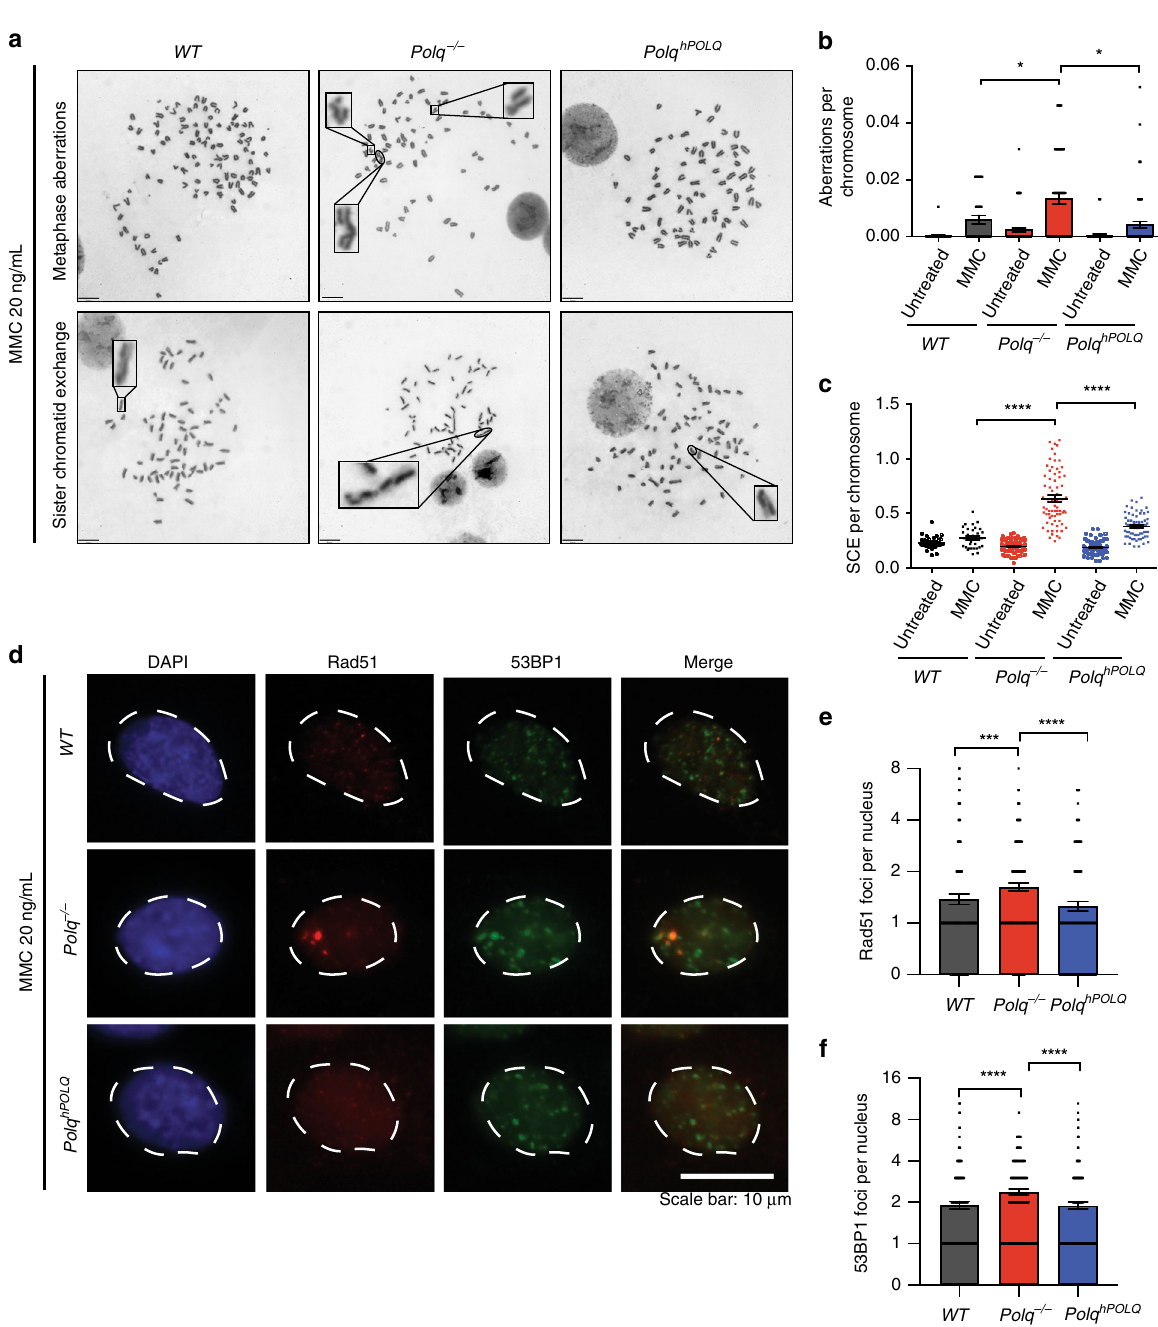
Fig. 4 Polq is required for Mitomycin C induced DNA damage repair. a Metaphase aberrations and sister chromatid exchanges are shown in WT , Polq − / − and Polq hPOLQ cells 12 h after treatment with 20 ng/mL Mitomycin C (MMC). Scale bar = 10 µ m. b , c Quanti fi cation of ( a ), 35 metaphase spreads for each condition was scored, and shown are mean ± SEM. Signi fi cance determined using an unpaired, two-tailed t -test (* p < 0.05; **** p < 0.0001). d IF analysis of WT , Polq − / − , and Polq hPOLQ cells six hours after treatment with 20 ng/mL MMC, stained with DAPI (blue) and antibodies speci fi c for Rad51 (red) and 53BP1 (green) ( n = 3 biologically independent experiments). ( e , f ) are quanti fi cation of ( d ). Statistical signi fi cance was assessed by unpaired,